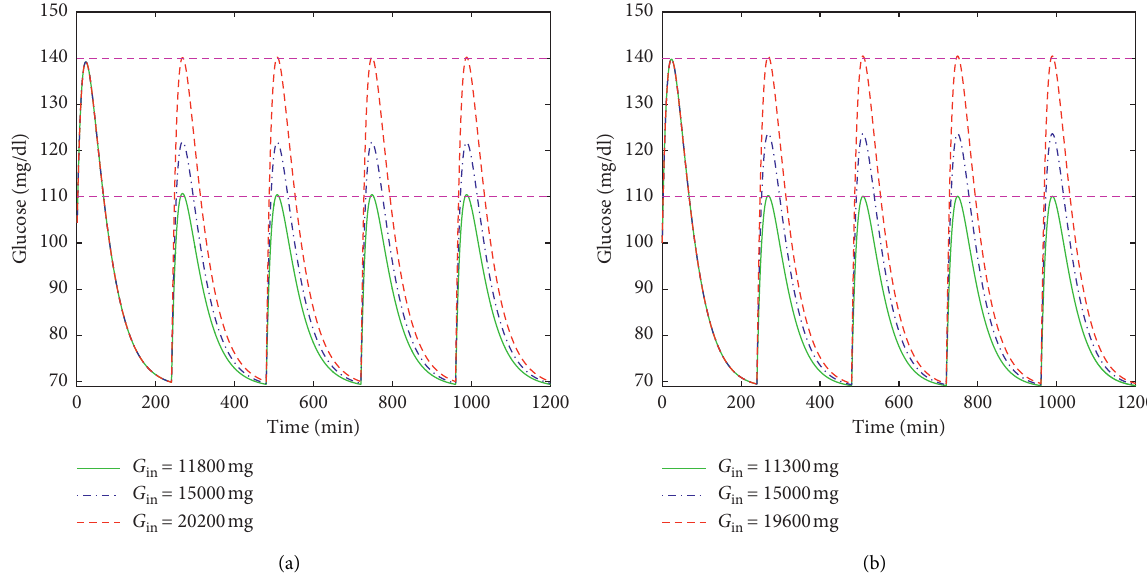
Figure 8: Range of glucose intake amount for maintaining normal glucose level when τ � 240min: (a) range of glucose intake amount of system (5) and (b) range of glucose intake amount of system (8).